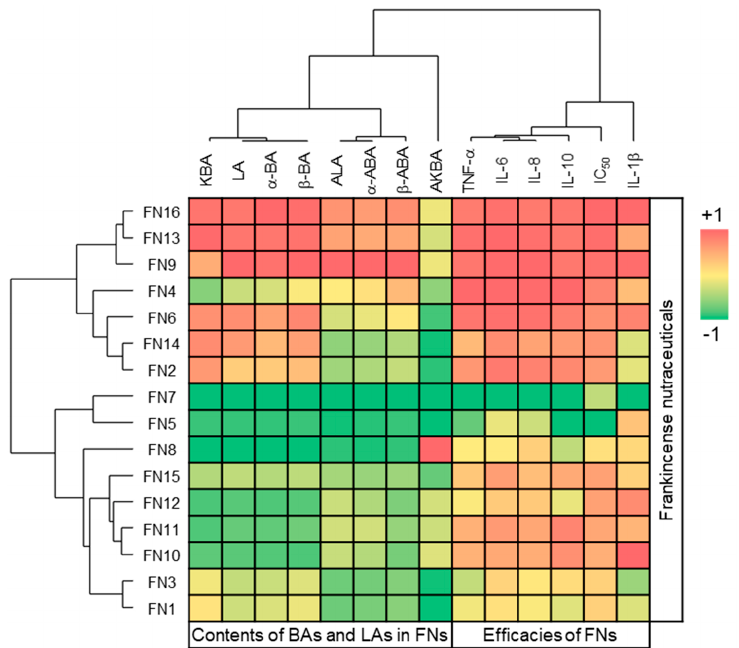
Figure 5. Heatmap visualizing correlations between BAs and LAs compositions in FNs and FN efficacies with respect to inhibition of cytokine release and cancer cell toxicity. Cluster analysis of variables (BAs, LAs, cytokines, IC 50 ) was performed with distances of correlation coefficients and complete linkage. Cluster analysis of objects (FN1-16) was performed with standardized variables, Euclidean distances, and complete linkage. All data were standardized and efficacy values were additionally inverted. +1 indicates high contents of BAs and LAs in FNs or high efficacies of FNs, − 1 indicates low contents or efficacies. BAs and LAs contents were analyzed by HPLC-MS/MS; IC 50 toxicity against MDA-MB-231 breast cancer cells was determined by XTT (72 h); and inhibition of cytokine release by PBMC was analyzed after 18 h by flow cytometry.